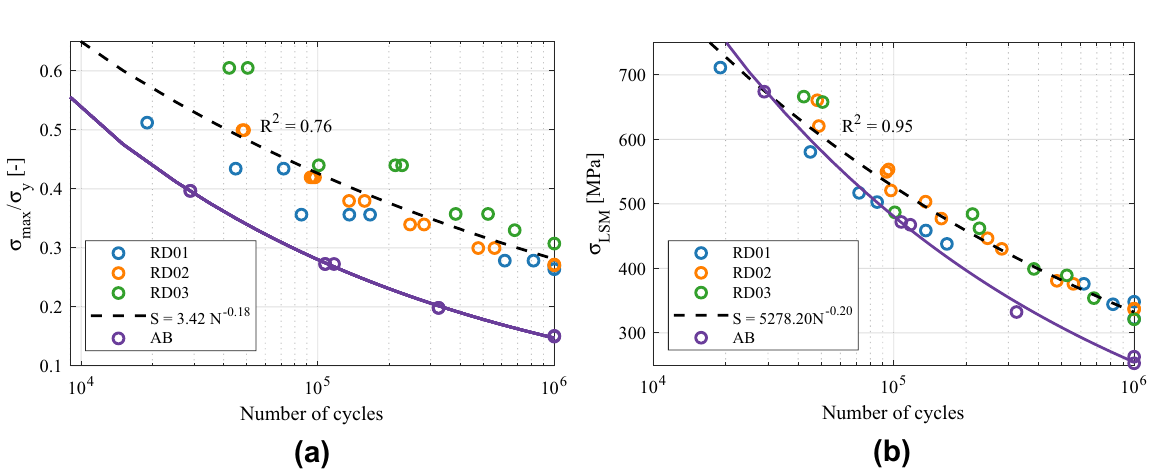
Figure 13. S–N curves of collapse of the structures normalized by ( a ) yield strength and ( b ) Local Stress